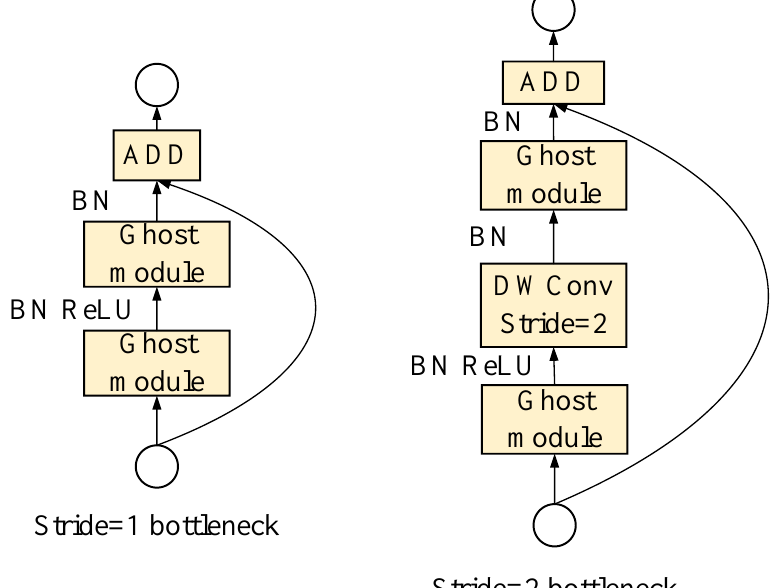
Figure 4. Ghost Bottleneck.